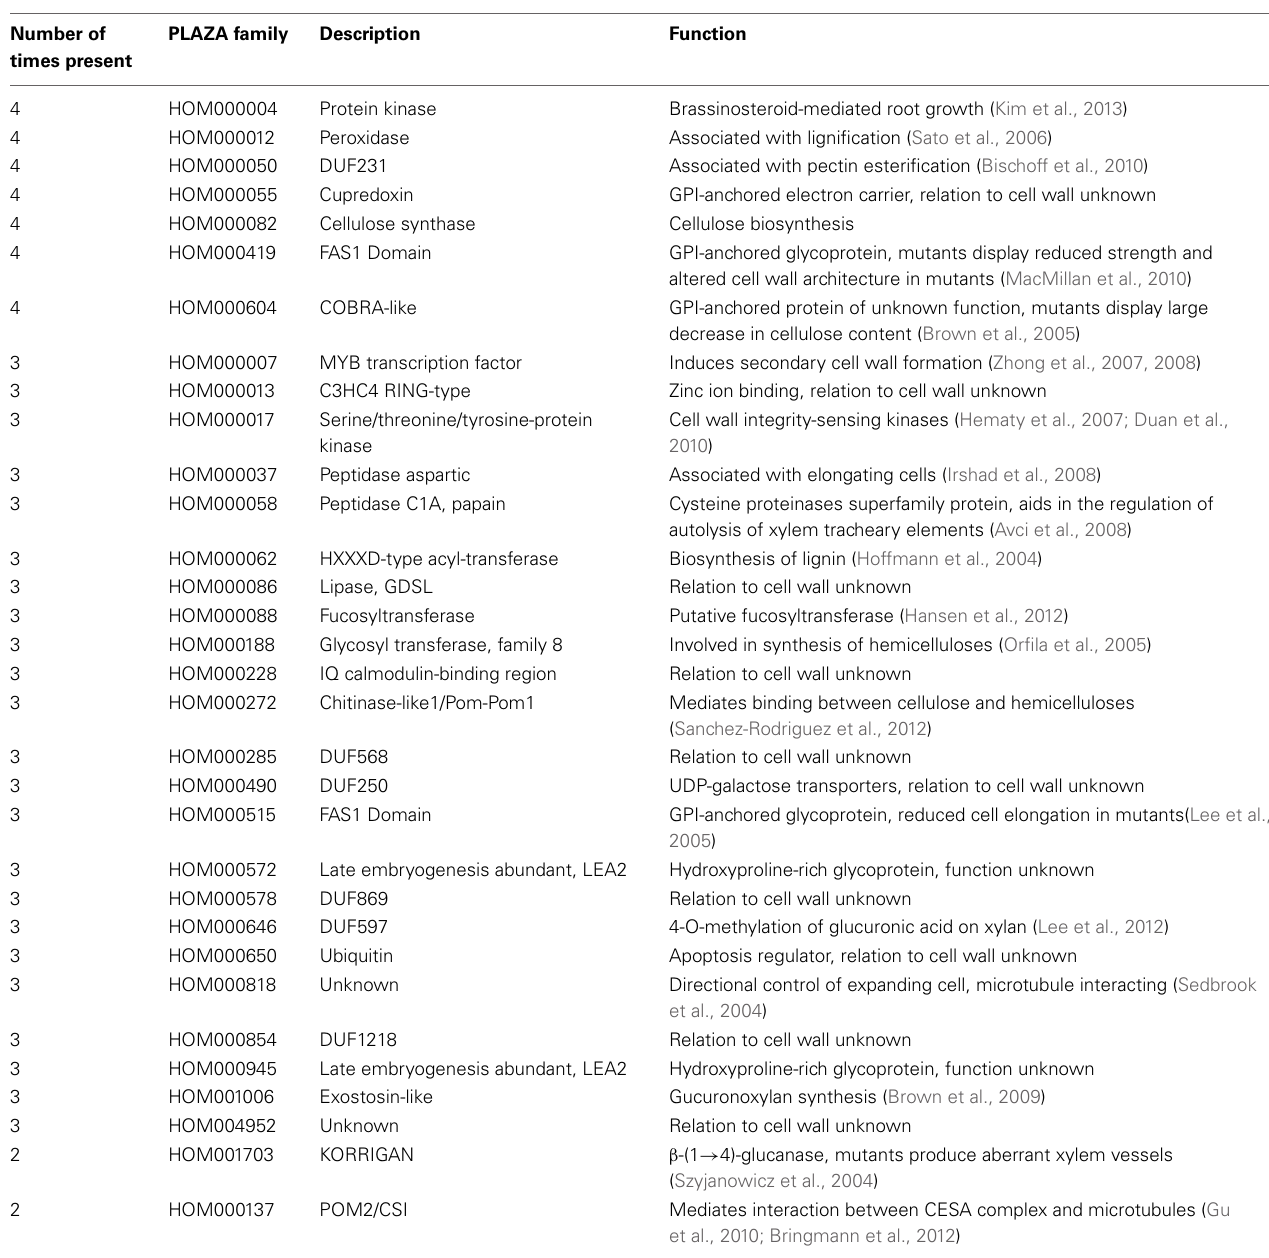
Table 1 | Annotation of the families enriched in the four